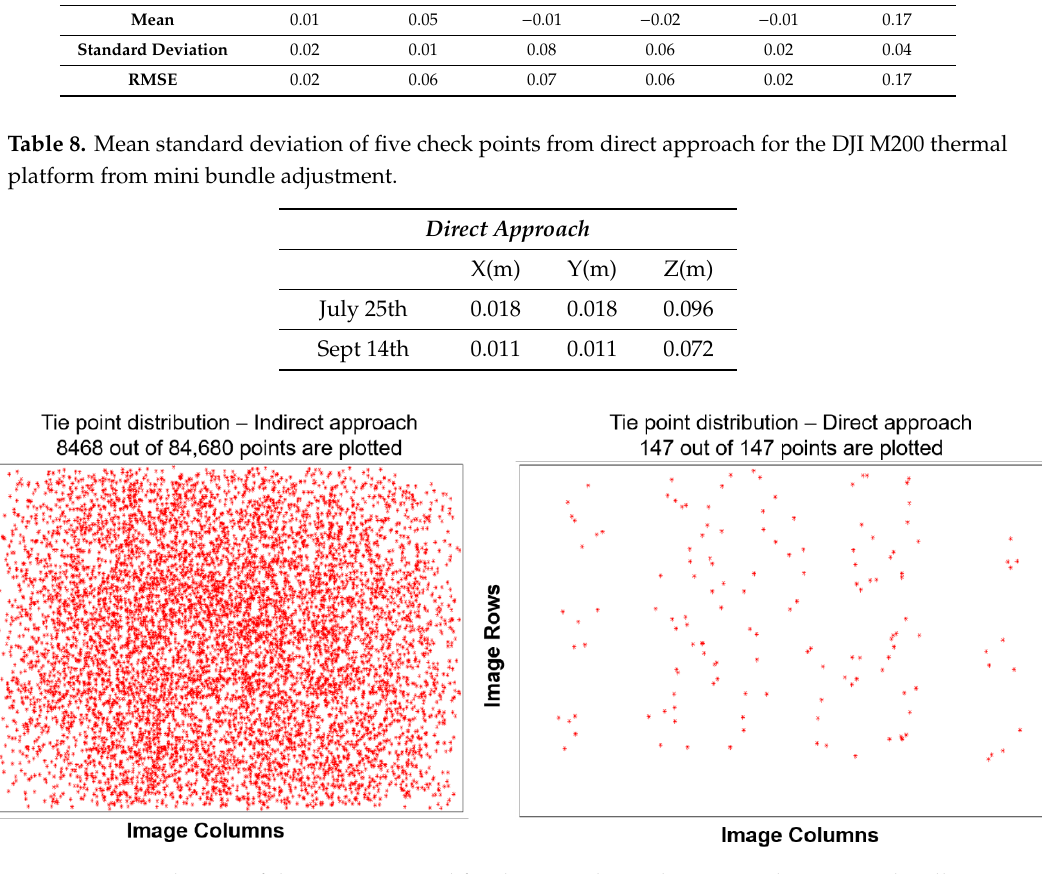
Figure 16. Distribution of the tie points used for the FLIR thermal sensor in the Sept. 14th collection date for the direct ( right ) and indirect* ( left ) approaches (*only 10% of total tie points are plotted).